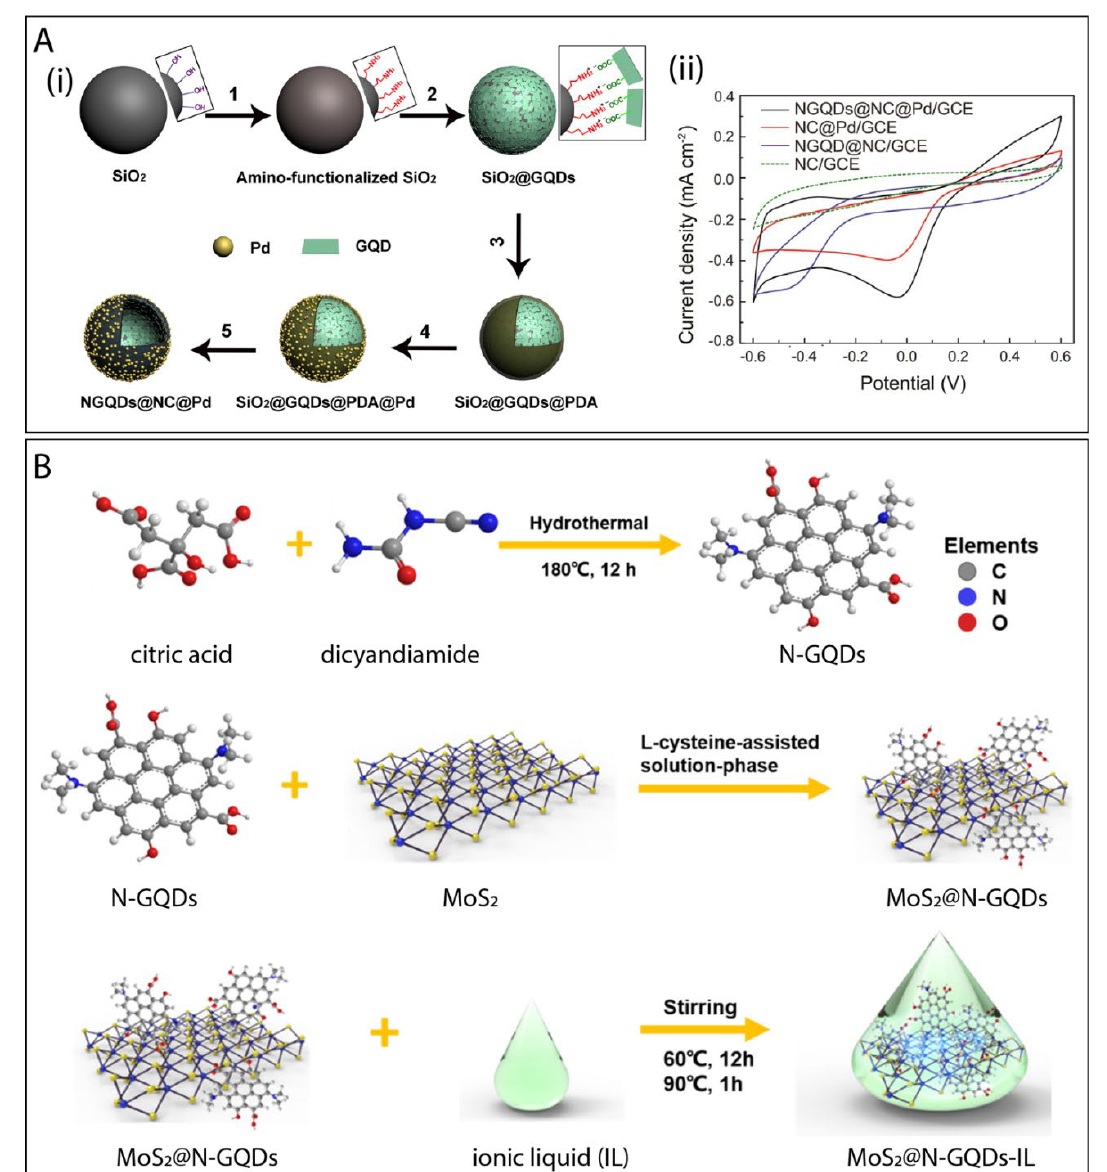
Figure 8. ( A ) ( i ) Schematics illustrating the preparation process of NGQDs@NC@Pd HNSs: (1) Amino functionalization of SiO 2 nanospheres; (2) wrapping SiO 2 nanospheres with GQD nanosheets; (3) coating of PDA on the surface of SiO 2 @GQD; (4) loading of Pd NPs on the surface of SiO 2 @GQD@PDA; (5) further carbonization and HF etching to form NGQD@NC@Pd HNSs and ( ii ) CV curves of the nanocomposites in PBS containing 1.0 mmol L -1 H 2 O 2 . Reproduced with permission from reference [223]. Copyright 2016 American Chemical Society. ( B) Schematic representation of the synthetic proce- dure employed for the preparation of MoS 2 @N-GQDs-IL. Reproduced with permission from reference [183].